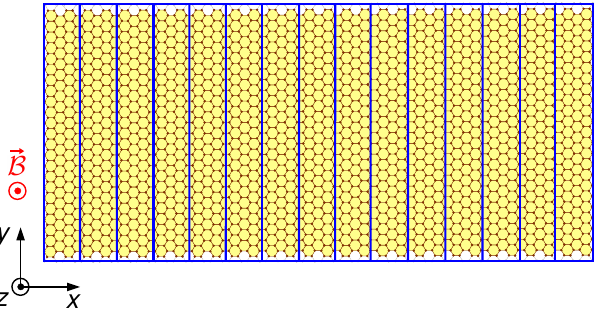
Figure 1. Subdivision of a graphene ribbon into